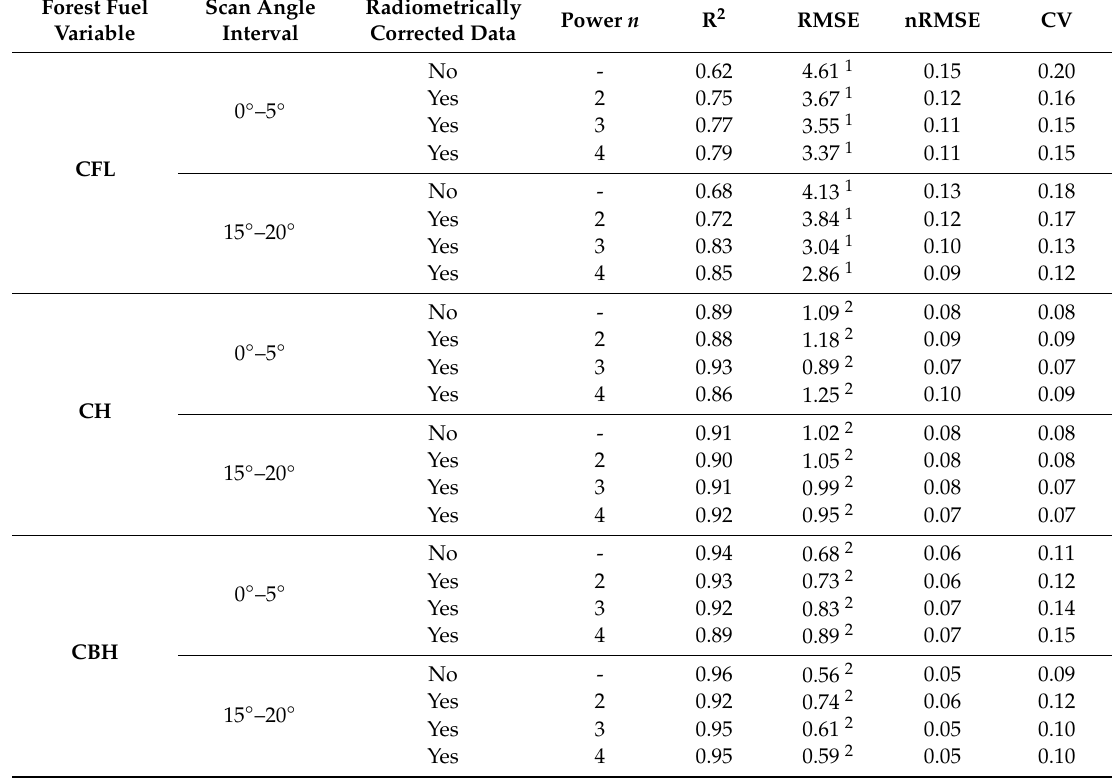
Table 4. Prediction of forest fuel variables (i.e., CFL, CH, and CBH) using varied scan angle interval and radiometric